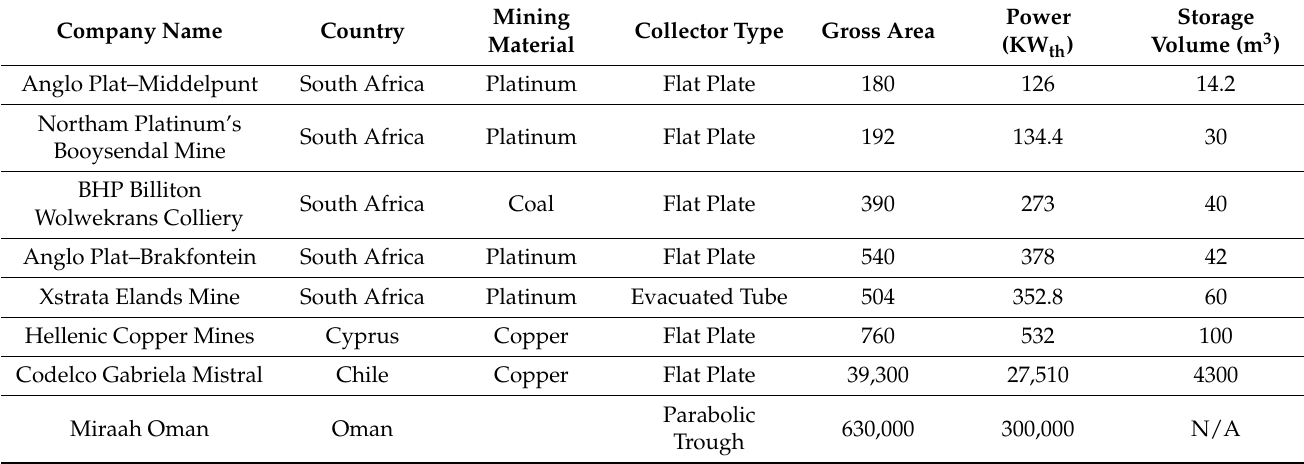
Table 6. SHIP plants in mining industry with process-level integration